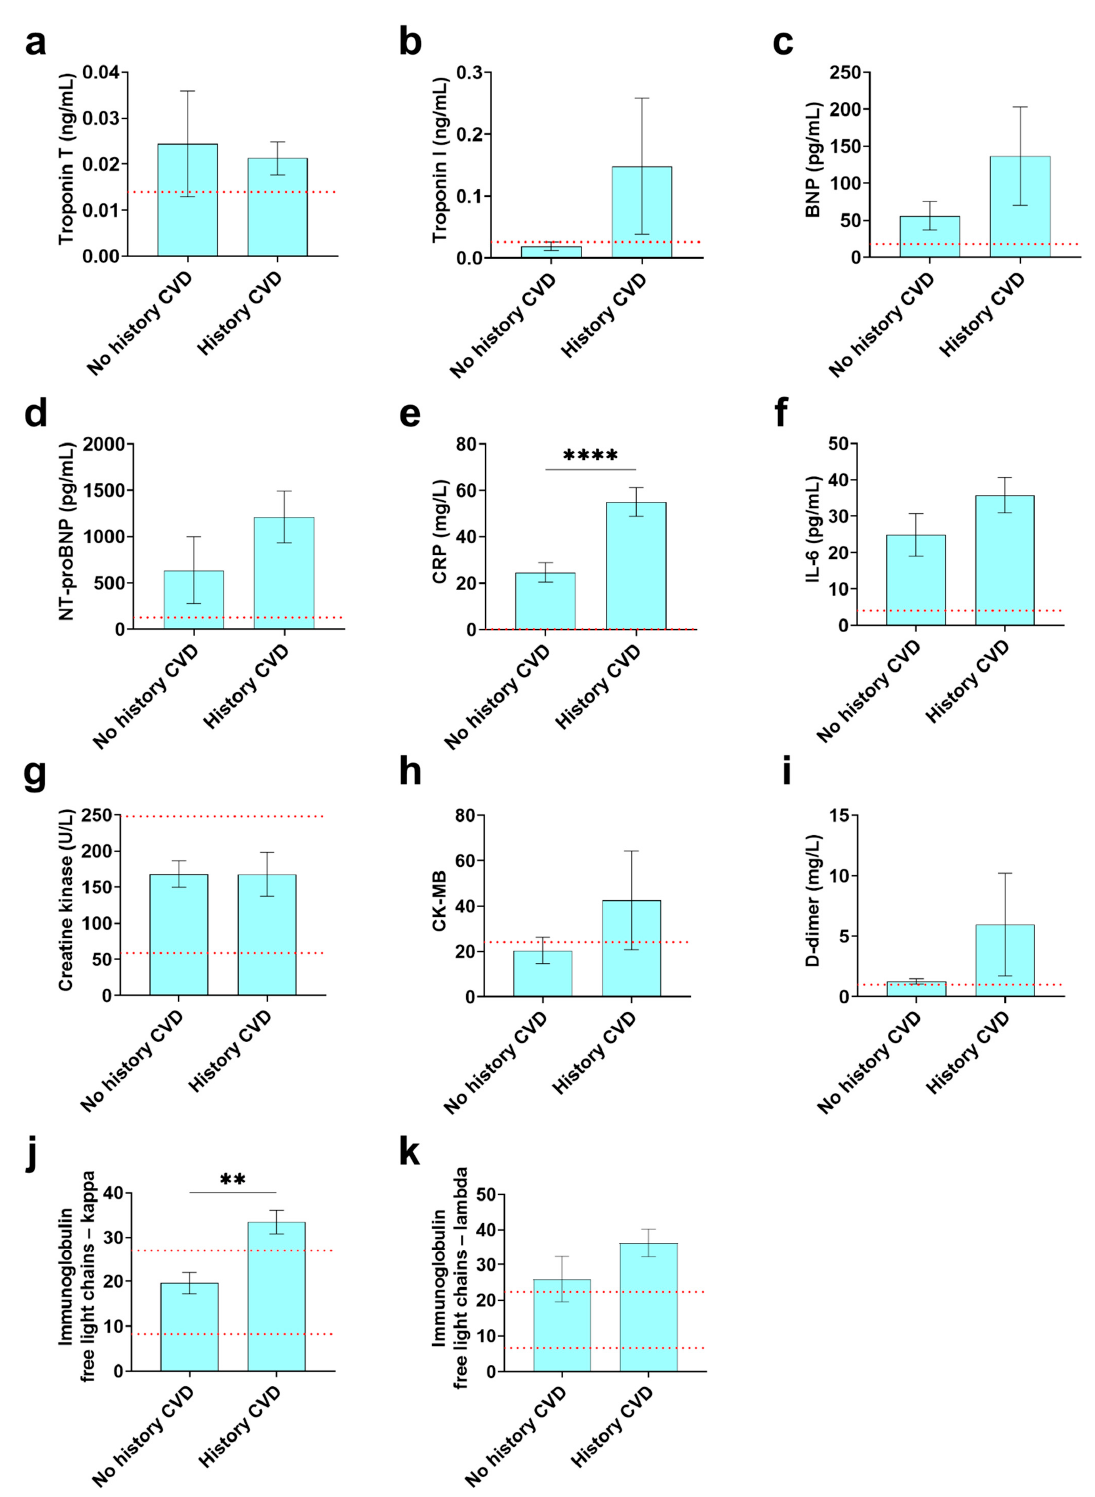
Figure 3. Patients regardless of history of CVD patients had elevated cardiac biomarkers. Cardiac and inflammatory biomarker levels were compared between patients with a history of CVD and those without CVD for ( a ) troponin T ( n = 7/11), ( b ) troponin I ( n = 9/17), ( c ) BNP ( n = 13/8), ( d ) NT-proBNP ( n = 29/47), ( e ) CRP ( n = 184/103), ( f ) IL-6 ( n = 84/37), ( g ) creatine kinase ( n = 178/60) ( h ) CK-MB ( n = 14/16), ( i ) D-dimer ( n = 154/57), ( j ) kappa immunoglobulin FLC ( n = 4/10), and ( k ) lambda immunoglobulin FLC ( n = 6/10). Data shown as mean ± SEM by Student’s t test. Red dotted line: reference range for biomarker. (**, p < 0.01, ****, p <